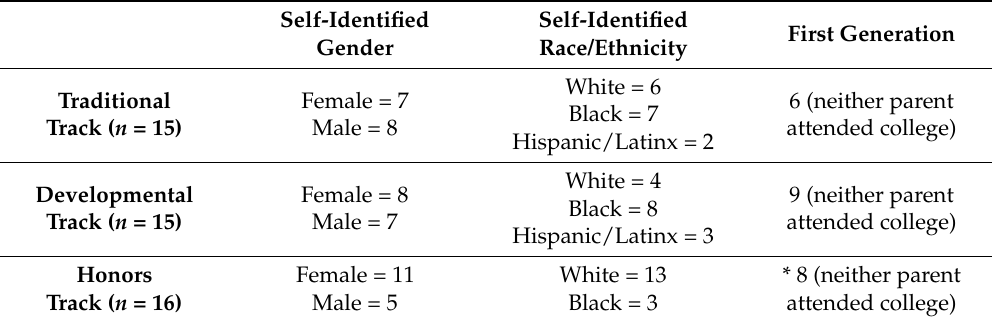
Table 2. Student Participant Demographics by